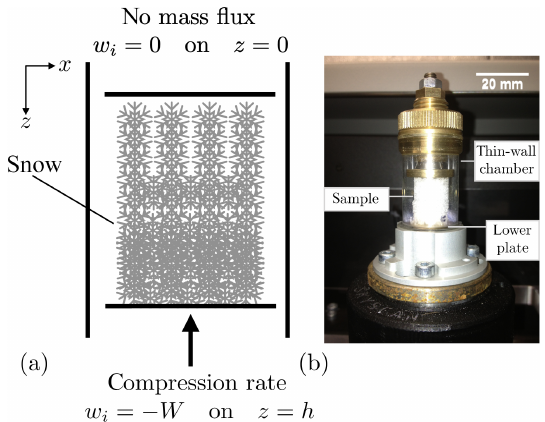
Figure 1. Schematic diagram of the snow French press: (a) ideal- ized framework for the theory, including the boundary conditions; and (b) experimental setup from Wang and Baker (2013) showing the snow sample housed within the sample chamber and the up- ward motion of the lower plate. The sample is small enough that the effects of gravity can be ignored. The top and bottom plates are impermeable, but air can flow out of the sides of the snow